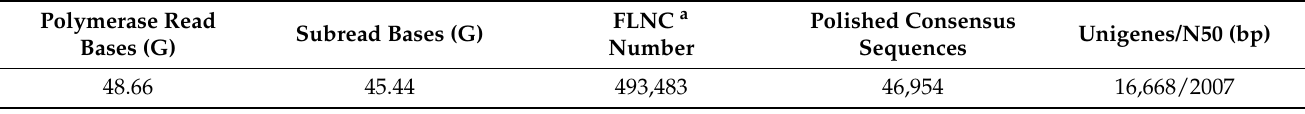
Table 1. Summary of the Heterosigma akashiwo single-molecule real-time sequencing data.